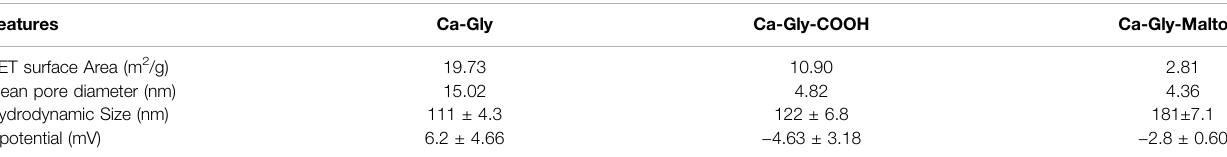
TABLE 1 | Overview of the main features of the uncoated and coated BioMOFs.